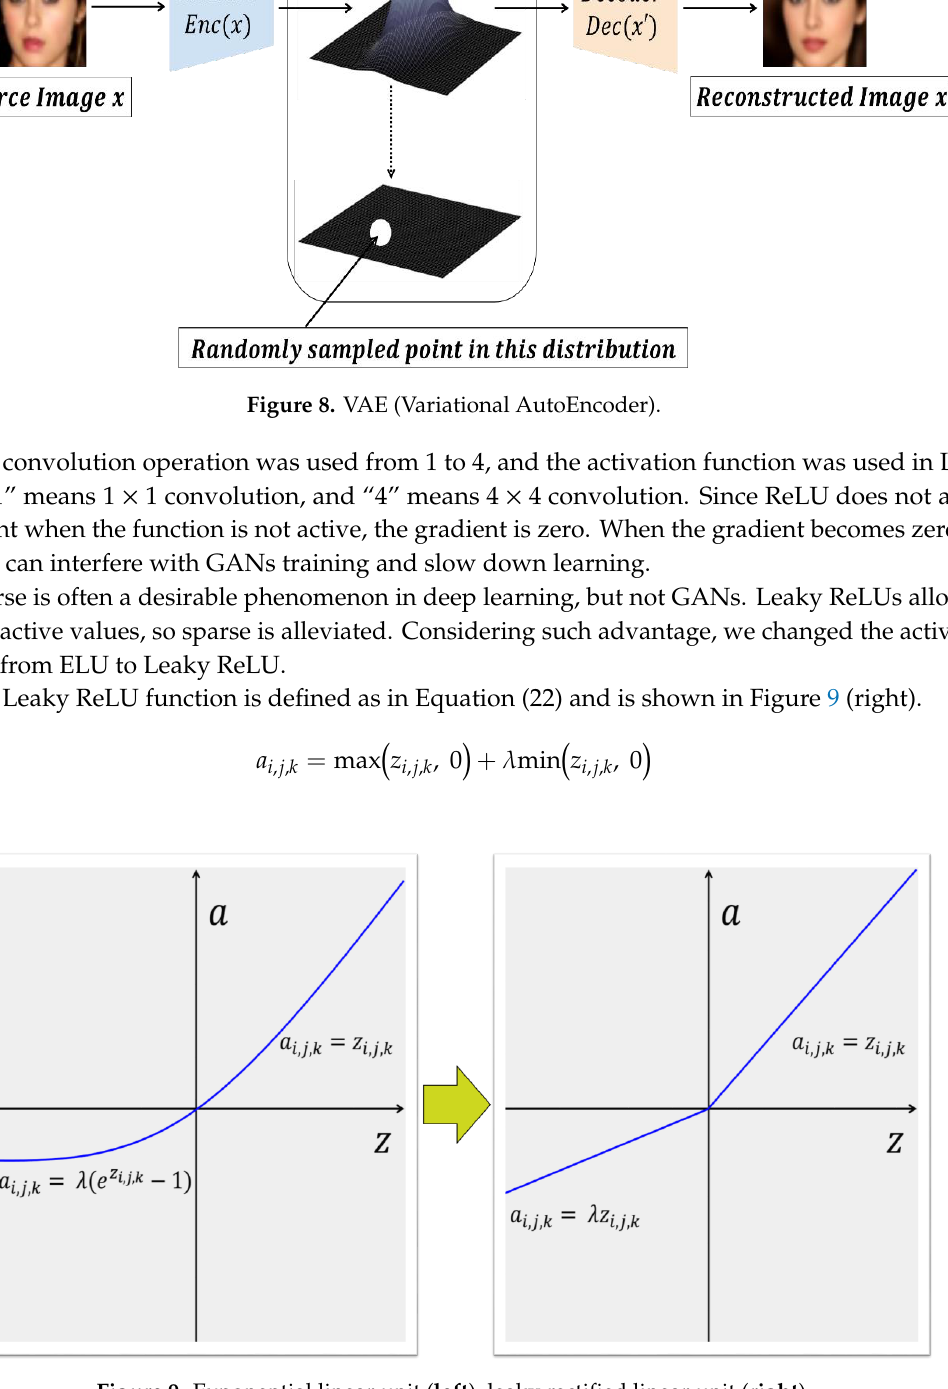
Figure 7. Discriminator structure of the proposed model.